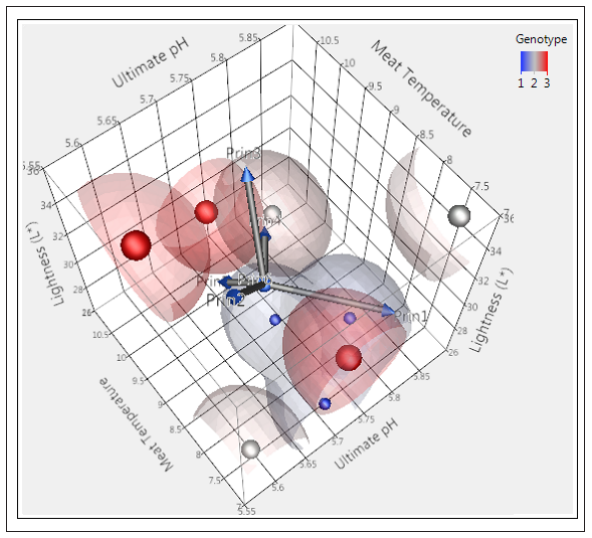
The first three principal components of beef Muscularis longis- simus thoracis et lumborum muscle from bulls for meat attri- butes related to meat